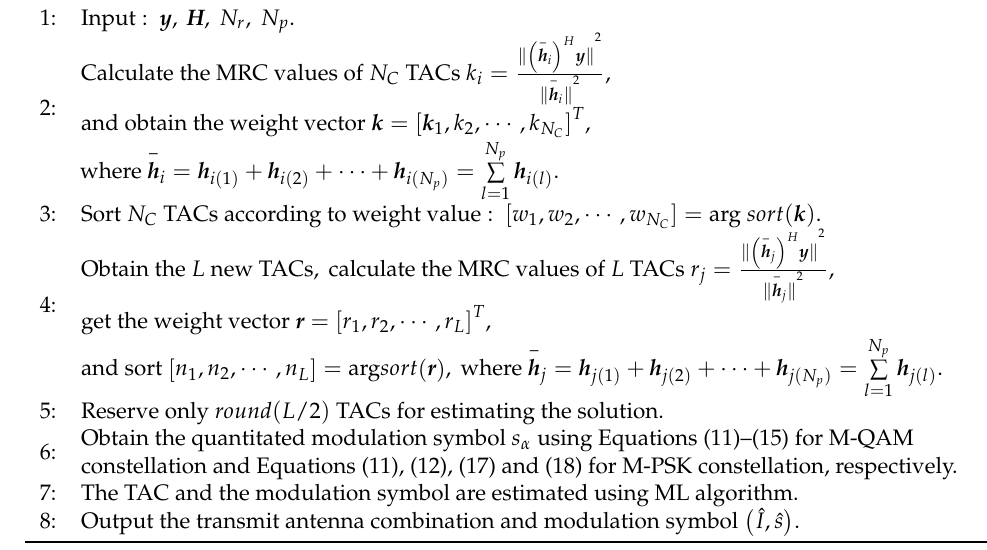
Table 1. Proposed MRC-RS